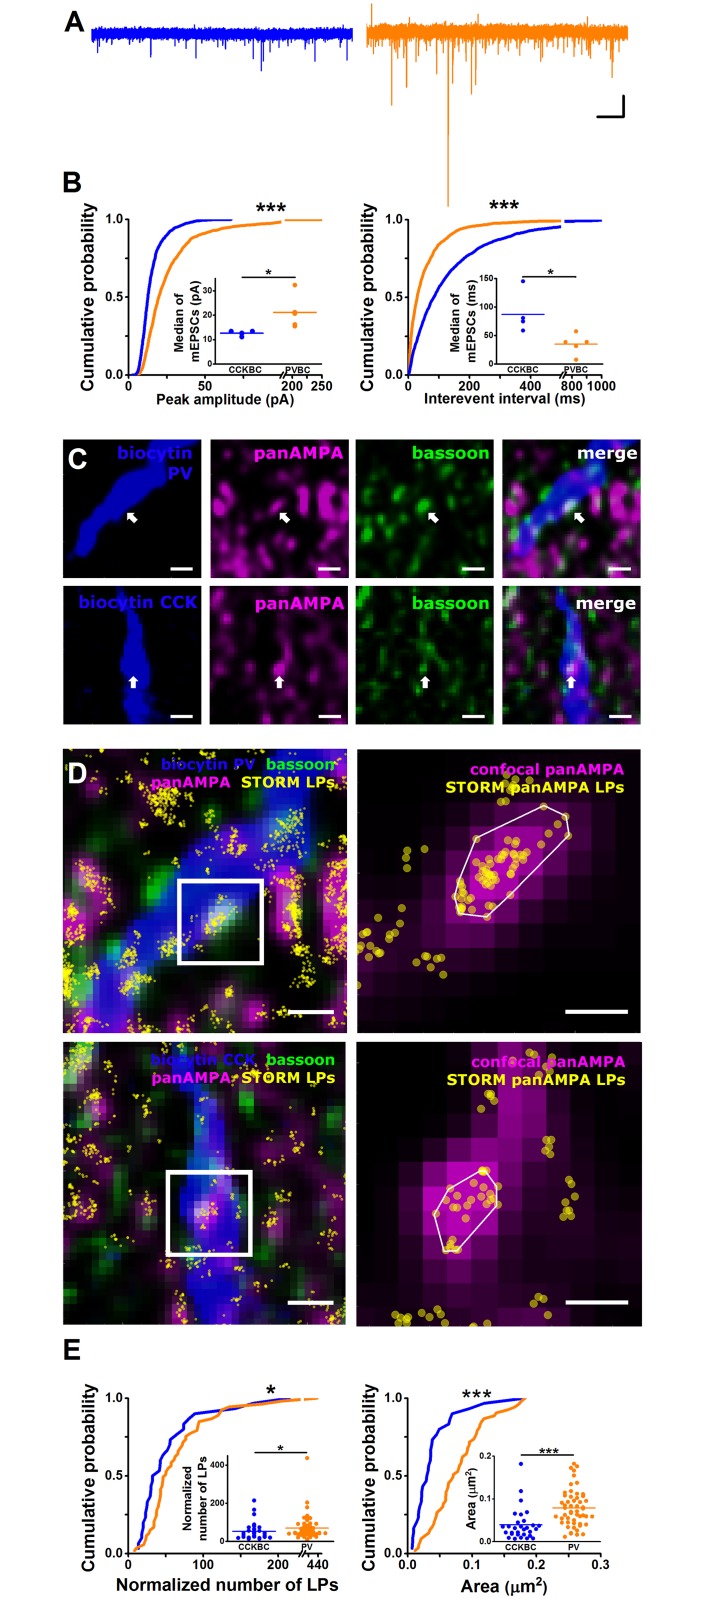
Excitatory inputs of the 2 basket cell (BC) types have distinct properties.(A) Representative traces depicting miniature excitatory postsynaptic currents (mEPSCs) in the presence of 0.5 μM tetrodotoxin (TTX) in a cholecystokinin-expressing basket cells (CCKBC) (left, blue) and in a parvalbumin-containing basket cells (PVBC) (right, orange) (holding potential, –65 mV). Scales: x: 0.5 s, y: 30 pA. (B) Cumulative probability distributions of mEPSC peak amplitudes (left) and interevent intervals (right) obtained in CCKBCs (blue, n = 5) and PVBCs (orange, n = 5). PVBCs receive mEPSCs with larger amplitude and at higher frequency than CCKBCs (Kolmogorov-Smirnov test, ***p < 0.001). Data points in the insets represent the median of the cumulative distributions obtained for each cell, and lines indicate means (peak amplitude: CCKBCs, 12.62 ± 0.43 pA, n = 5, PVBCs, 21.19 ± 3.01 pA, n = 5; interevent interval: CCKBCs, 86.97 ± 15.03 ms, n = 5; PVBCs, 34.87 ± 8.02 ms, n = 5; Mann–Whitney U test, *p < 0.05) (S5 Data). (C) Examples of deconvolved confocal images showing bassoon-apposing puncta immunostained for α-amino-3-hydroxy-5-methyl-4-isoxazolepropionic acid (AMPA) receptors in a dendritic portion of a PVBC (arrows, upper panels) and a CCKBC (arrows, lower panels). Scale bars: 0.4 μm. (D) Left, the same dendritic fragments shown in (C) with the superimposed stochastic optical reconstruction microscopy (STORM) images obtained for AMPA receptor staining (yellow), aligned and filtered using VividSTORM. Right, higher magnification of representative puncta depicting AMPA receptors along the interneuron dendrites, showing the deconvolved confocal image aligned with the STORM image. Each yellow sphere corresponds to a localization point (LP), while the white lines delineate the 2D convex hull area based on the AMPA LP clusters. Scales: left 0.5 μm, right 0.2 μm. (E) Cumulative probability distributions of the normalized number of LPs (left) and 2D convex hull area (right) obtained in CCKBCs (n = 30 puncta, blue) and PV-expressing interneurons (n = 53 puncta, orange). AMPA receptor clusters on CCKBC dendrites are smaller and contain lower number of LPs than those observed on parvalbumin (PV)-immunoreactive dendrites (normalized number of LPs: CCKBCs, 53.13 ± 8.58, PV-containing interneurons 69.28 ± 8.90; 2D convex hull area: CCKBCs, 0.04 ± 0.007 μm2, PV-containing interneurons, 0.08 ± 0.006 μm2; Kolmogorov-Smirnov test, *p < 0.05, ***p < 0.001) (S5 Data). Each data point in insets represents a cluster, and lines indicate means (Mann–Whitney U test, *p < 0.05, ***p < 0.001).